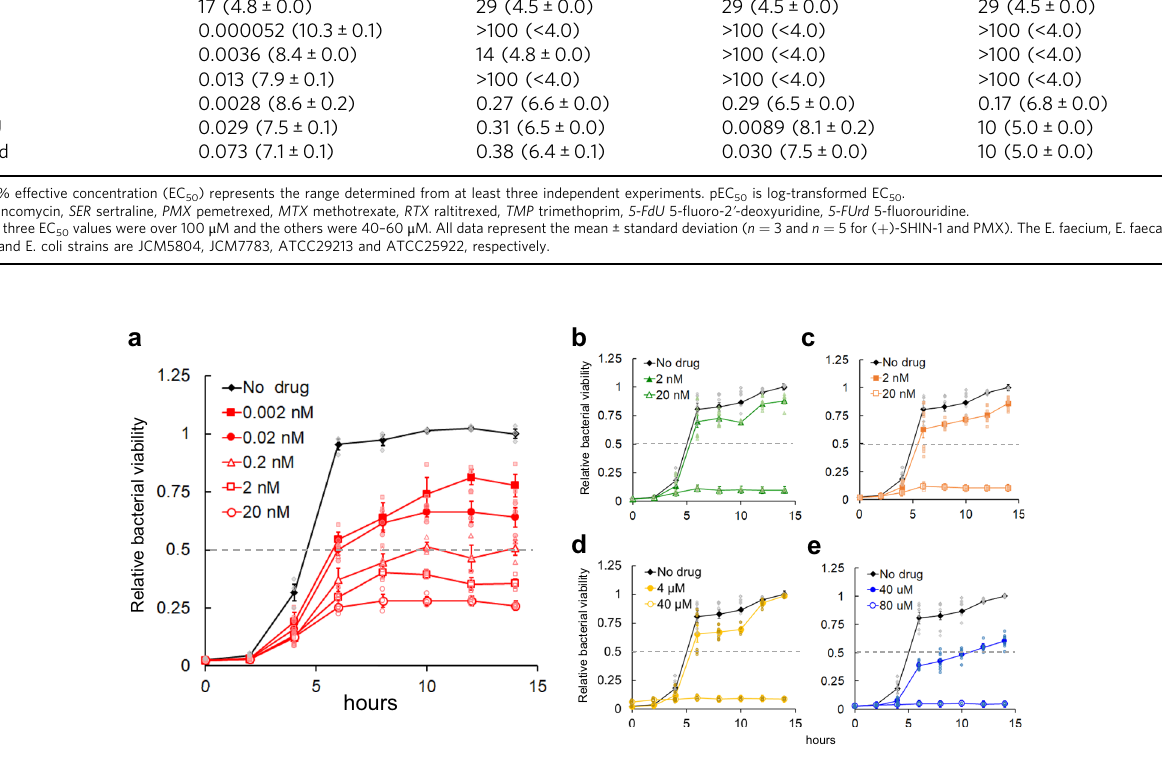
Fig. 2 The results of the bacterial viability assay. a Bacterial viability in the absence and presence of different ( + )-SHIN-1 concentrations. Grey and light red-coloured symbols are the values for calculating the average values and standard error of each point. ( n = 3) b – e Bacterial viabilities in the absence and presence of different MTX, TMP, SER and SHMT-IN-2 concentrations, respectively. Light green, light orange, dark yellow and light blue symbols show the values for calculating the average values and standard error of each point ( n = 8, n = 4 at 10 h) Error bars mean standard